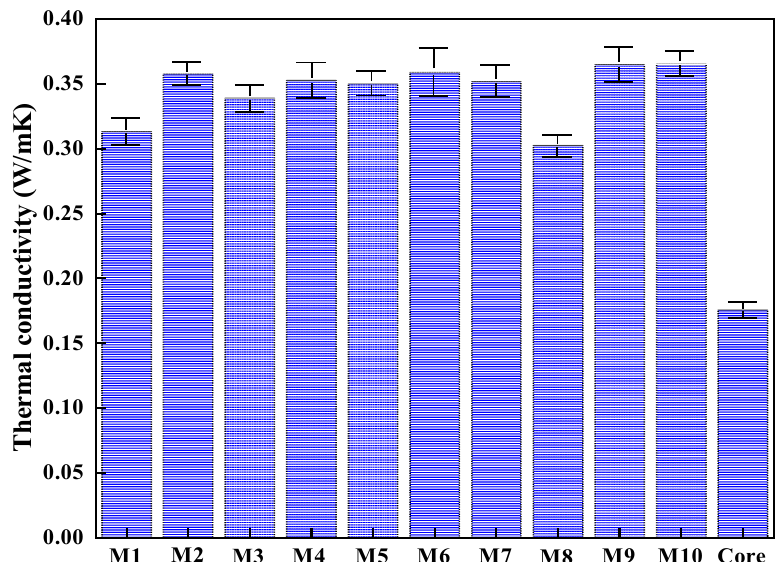
Nanomaterials 2021 , 11 , x FOR PEER REVIEW Figure 8. Thermal conductivity of different microcapsules and core material. Figure 8. Thermal conductivity of different microcapsules and core material.